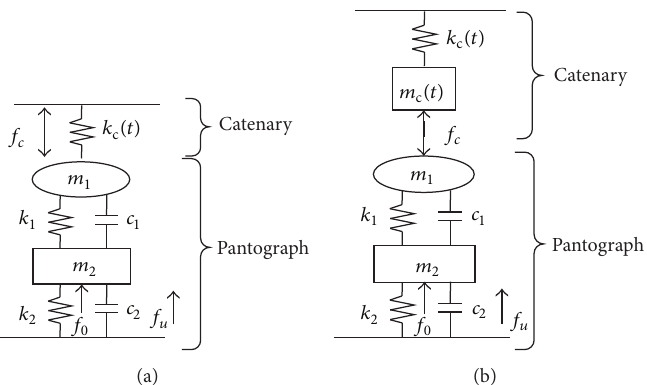
Figure 2: (a) Pantograph and simplified catenary model with time-varying stiffness. (b) Pantograph and simplified catenary model with time-varying stiffness and